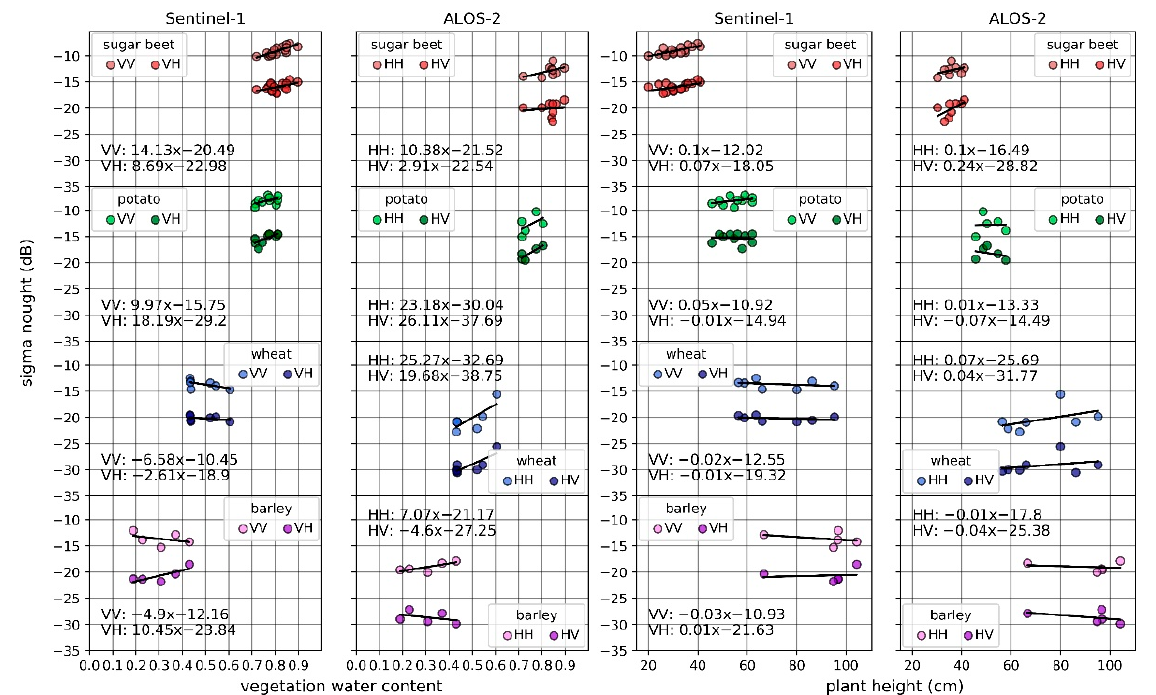
Figure 11. Scatter plots between vegetation water content (left) and plant height (right) and backscattering signal from co- and cross-polarized channels of C- and L-band satellite data.